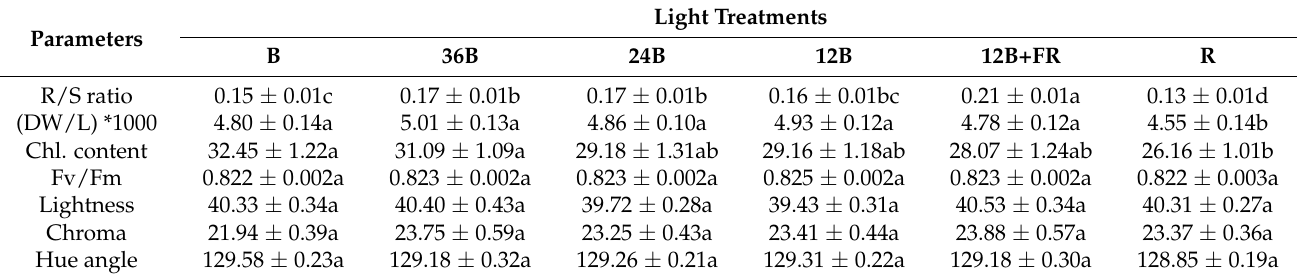
Table 2. Developmental, physiological, and colorimetric parameters of grafted watermelon seedlings treated for seven days in a healing chamber with six light treatments, plus seven days in a greenhouse. R/S: root-to-shoot ratio; DW/L: shoot dry weight-to-length ratio; chl: chlorophyll; Fv/Fm: maximum quantum yield of primary photochemistry of a dark-adapted leaf. Mean values ( ± SE) within a parameter followed by different letters are significantly different (a <